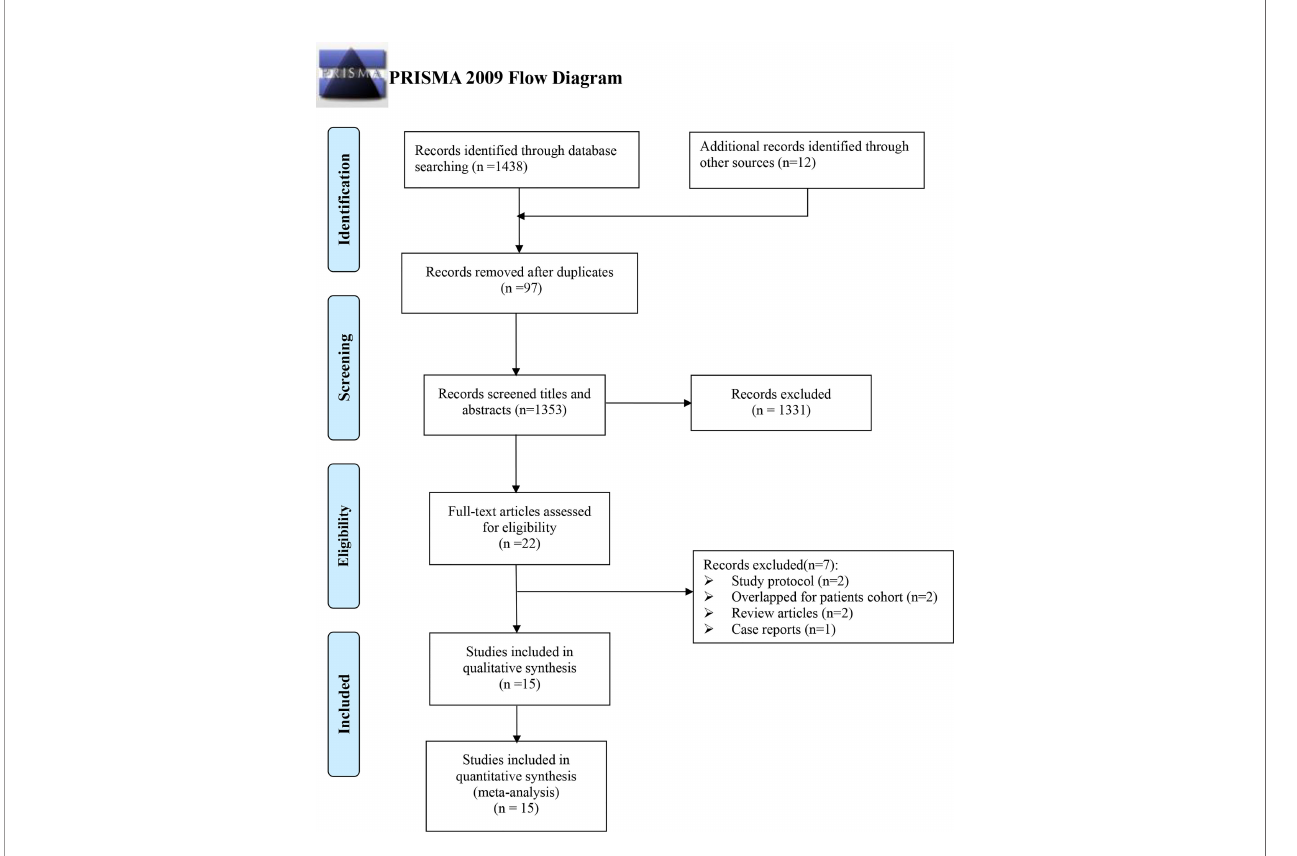
FIGURE 1 | Flow diagram for study